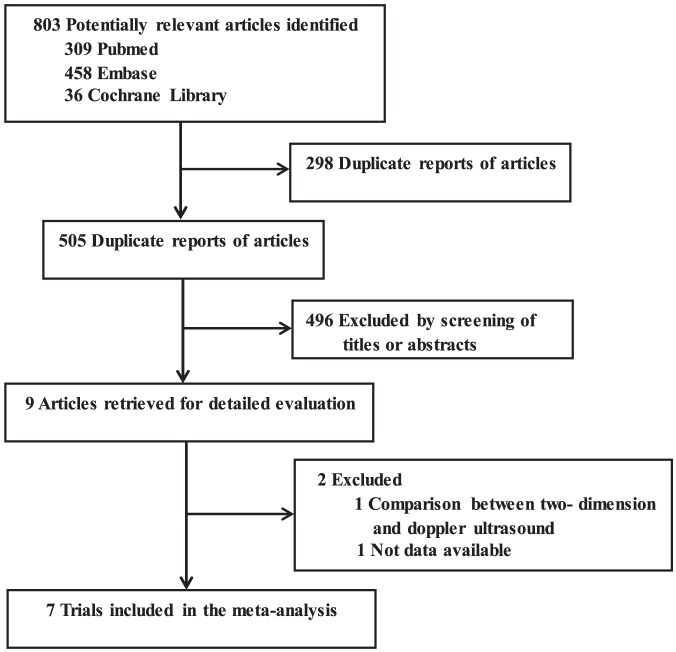
The flow diagram of the selection process of the included studies.